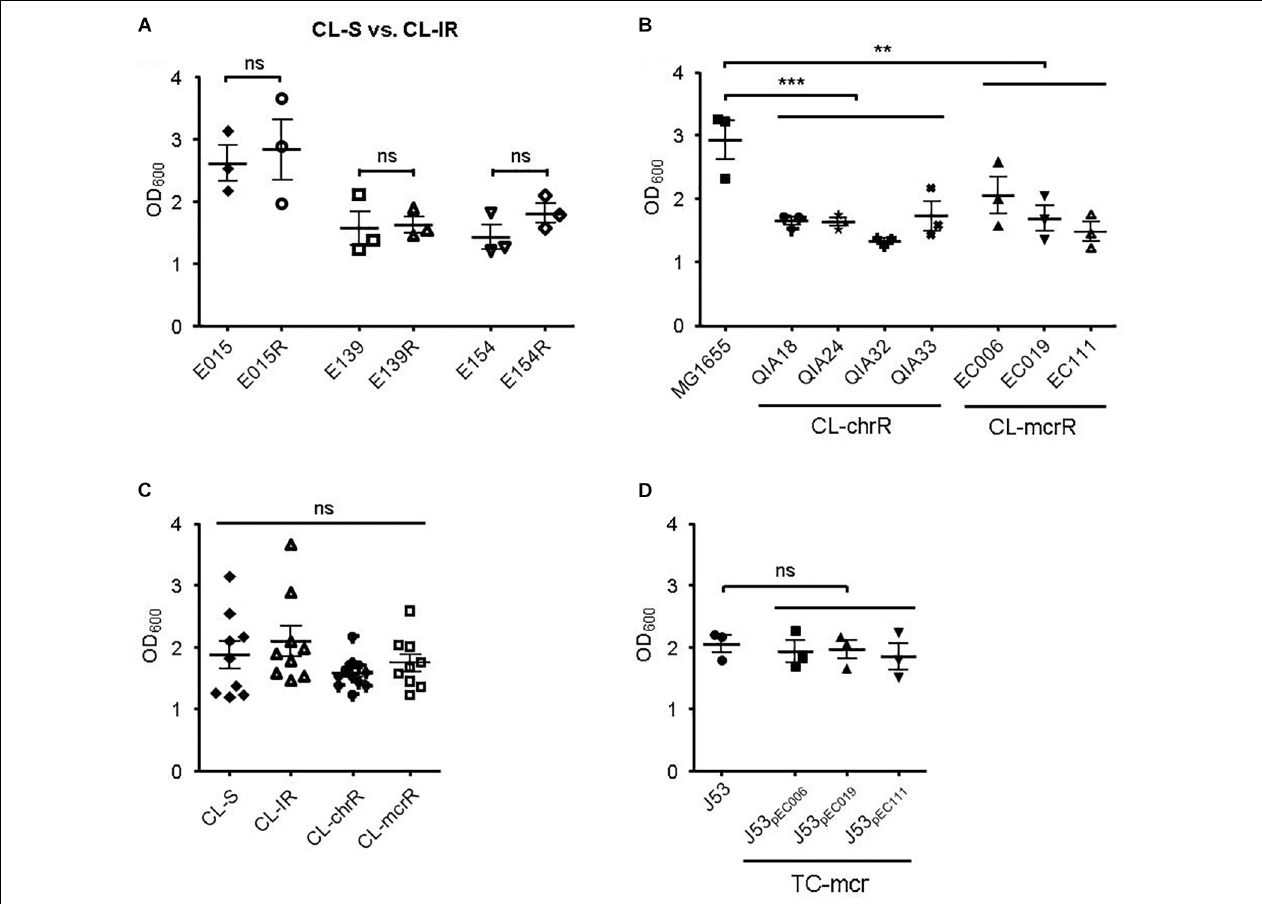
FIGURE 4 | Results of biofilm formation. (A) Comparison of biofilm formation between CL-S and CL-IR strains. (B) Biofilm formation of CL-chrR and CL-mcrR strains was compared with that of E. coli reference strain MG1655. (C) Comparison of biofilm formation among CL-S, CL-IR, CL-chrR, and CL-mcrR strains. (D) Biofilm formation of TC-mcr strains was compared with that of their recipient strain, J53. The error bars indicate the standard deviations. Statistical analyses were conducted with unpaired, two-tailed t -test. ** P ≤ 0.01; *** P ≤ 0.0001; ns, not